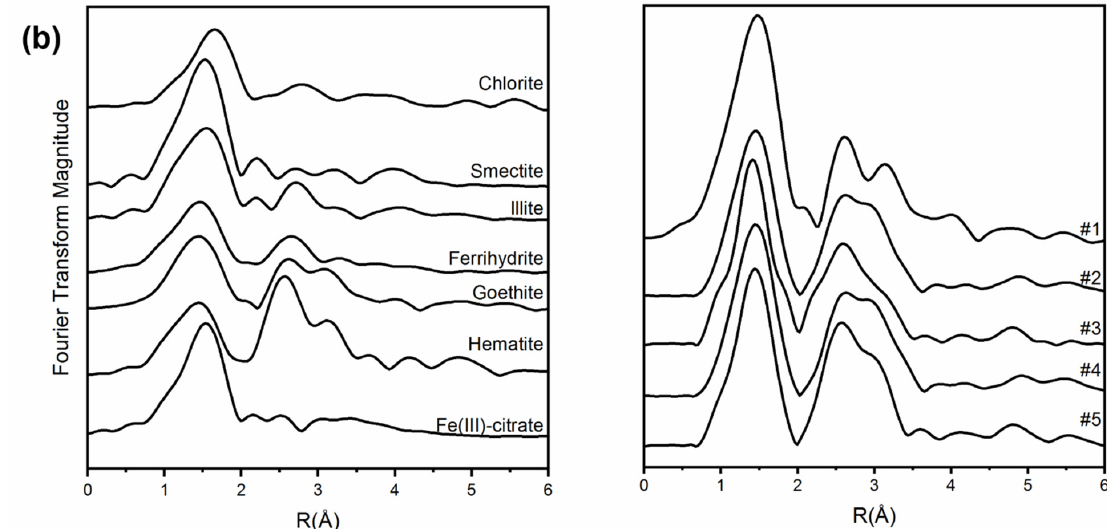
Figure 2. ( a ) Normalized Fe EXAFS spectra of both standards (on the left) and sediments (on the right). ( b ) Corresponding Fourier Transforms of both standards (left) and sediments (right).